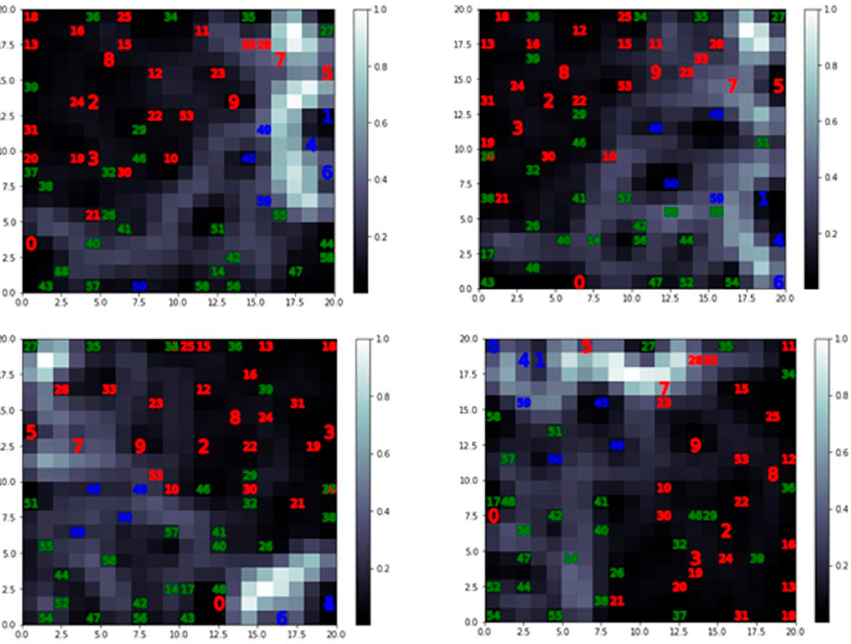
Figure 6. Result when applying SOM to the available data [23].